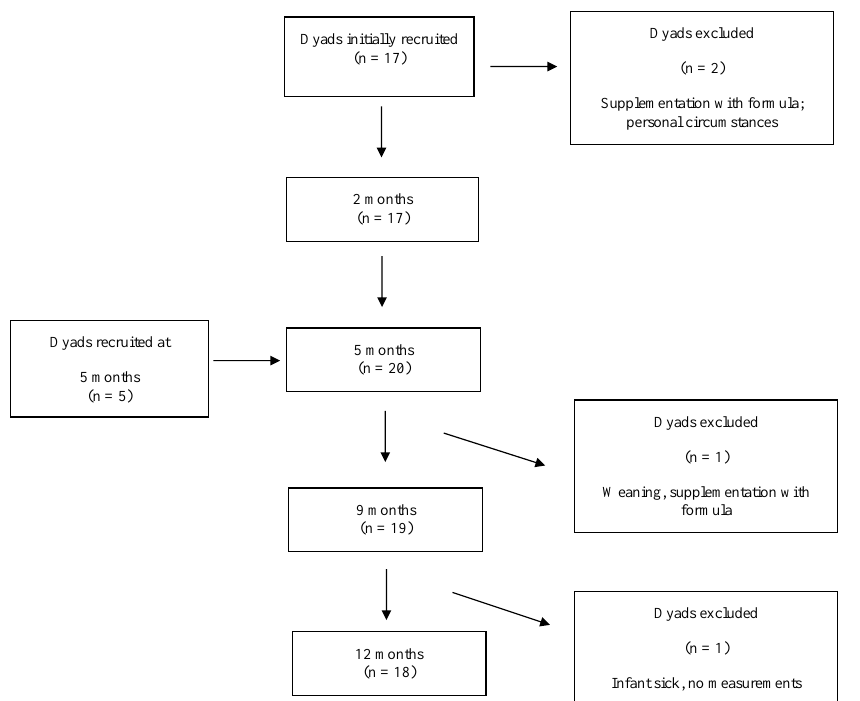
Figure A1. Flowchart of study